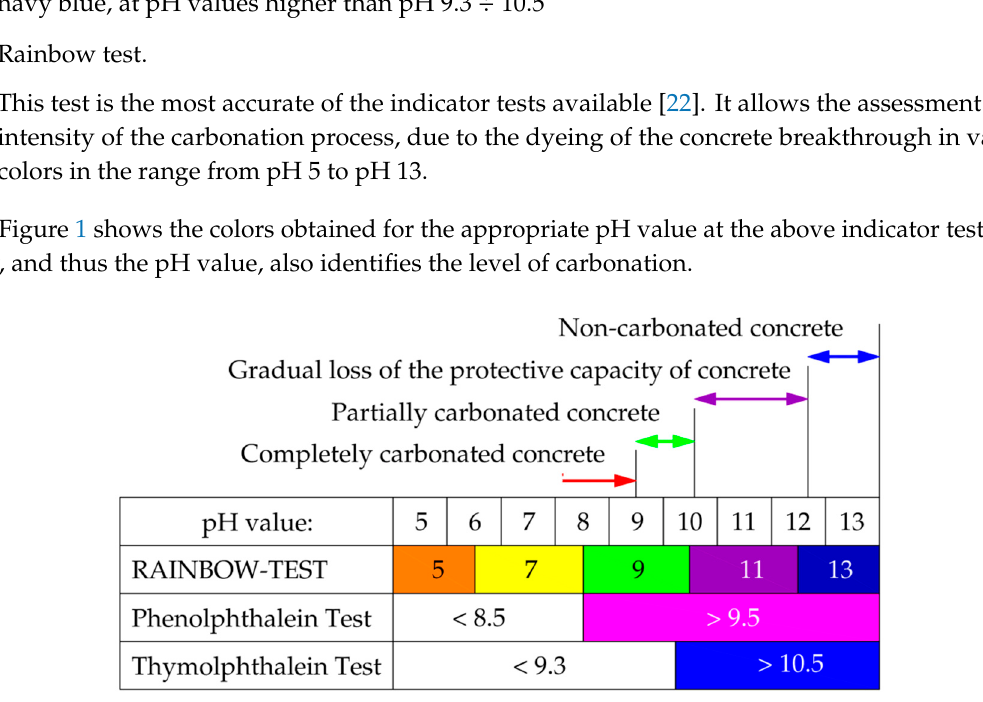
Figure 1. The colors used to determine the pH value of concrete and its carbonation level.